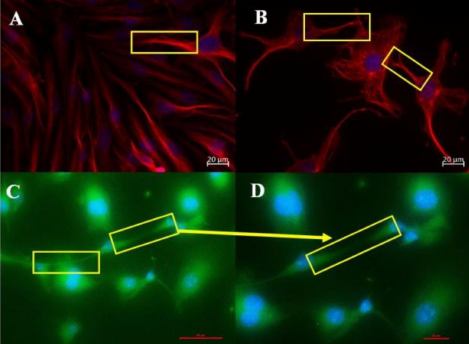
Figure 3. Immunofluorescence (IF) microscopy displays the α -tubulin and F-actin-rich cytoskeletal profile and molecular interaction between adjacent BECs that were grown on coated glass cover- slips. ( A ) represents the intracellular molecular profile of α -tubulin-based cytoskeletal projections and the interaction between adjacent BECs; ( B ) Illustrates an extensive tubulin-based cytoarchi- tecture that is anchored inside the cell and α -tubulin-rich NT extensions from the leading edges of the BEC membranes; ( C ) Shows the intracellular molecular profile of F-actin-rich cytoskeletal projections between adjacent BECs; ( D ) Shows the magnification of F-actin-based NT extensions between adjacent BECs. The yellow squares indicate zones of α -tubulin interaction ( A , B ) and F-actin interaction ( C , D ) between adjacent